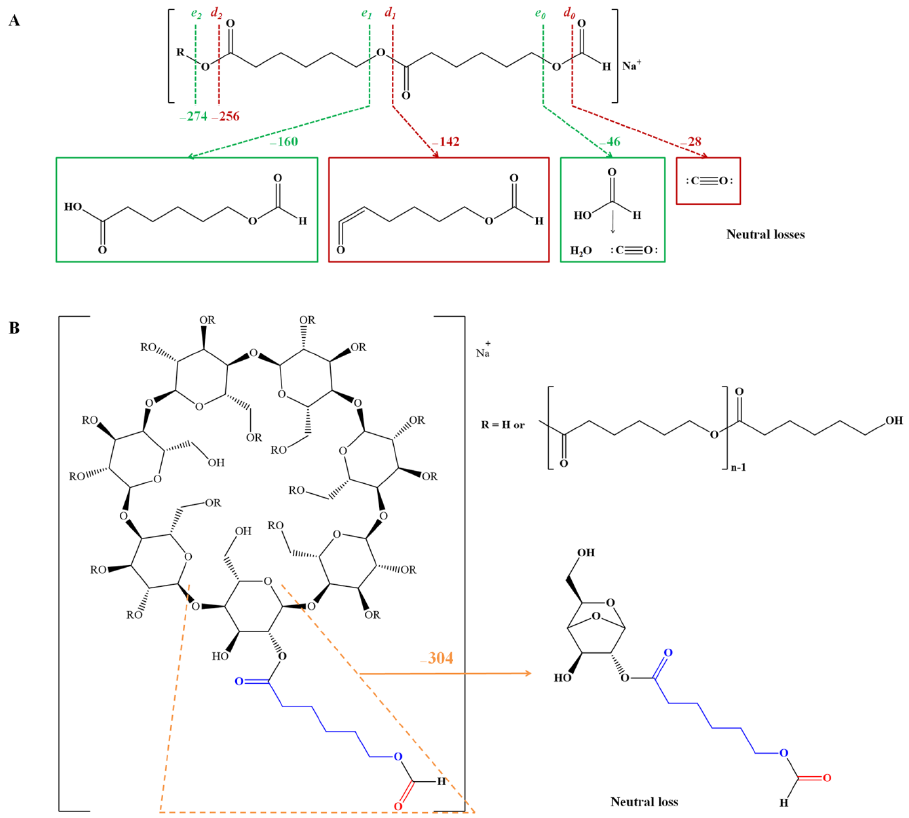
Scheme 4. Hypothetical fragmentation structures of neutral losses corresponding to secondary CDCL derivatives: ( A ) — fragmentation of the oligocaprolactone side chain and ( B ) — fragmentation of the substituted oligosaccharide